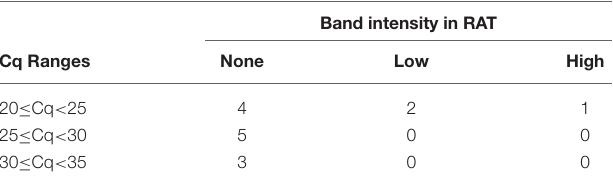
of the alpha (B.1.1.7) and beta (B.1.351) variants (18), showed no detection at Cq values between 29–35 (7) like this